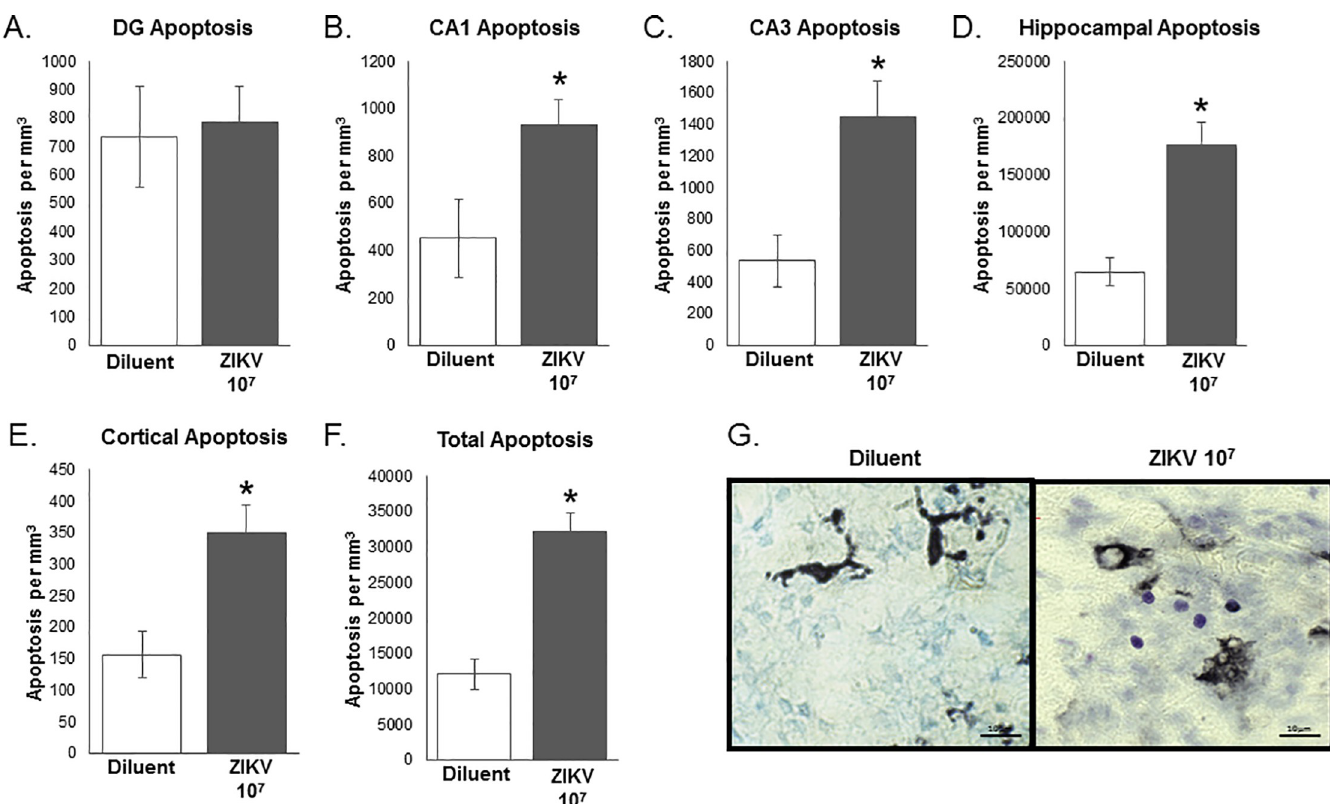
Fig 4. Assessment of apoptosis in hippocampal and cortical brain regions on postnatal day 2 in pups born of moms treated with ZIKV 10 7 or diluent control. (A) There was no significant difference in apoptosis within the DG between ZIKV-infected and uninfected control pups (F 1,10 = 0.053, P = 0.822). There was a significant increase in apoptosis per mm 3 in the ZIKV-treated pups compared to the diluent control pups in the CA1 ( B , F 1,10 = 5.833, P = 0.036), CA3 ( C , F 1,10 = 10.784, P = 0.008), cortex ( D , F 1,10 = 11.813 P = 0.006), whole hippocampus ( E , F 1,10 = 21.102, P = 0.001) and the total apoptosis measured across all brain regions combined ( F , F 1,10 = 36.118, P < 0.001). ( G ) Representative images of cresyl violent stain in diluent pup and ZIKV pup brain, images taken in DG of the hippocampus. n = 6 animals per group. � : p <